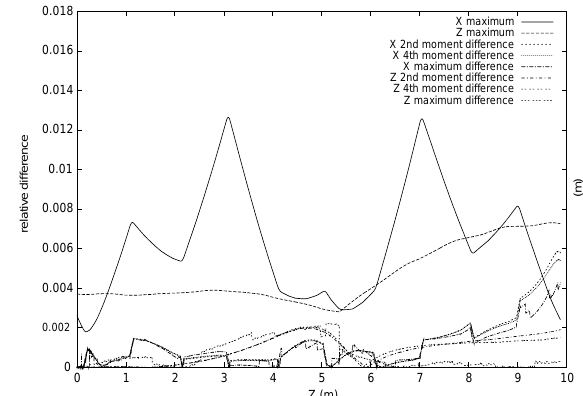
FIG. 9. The relative difference and maximum particle ampli- tude as a function of position with larger initial transverse emit- tance than the reference case.